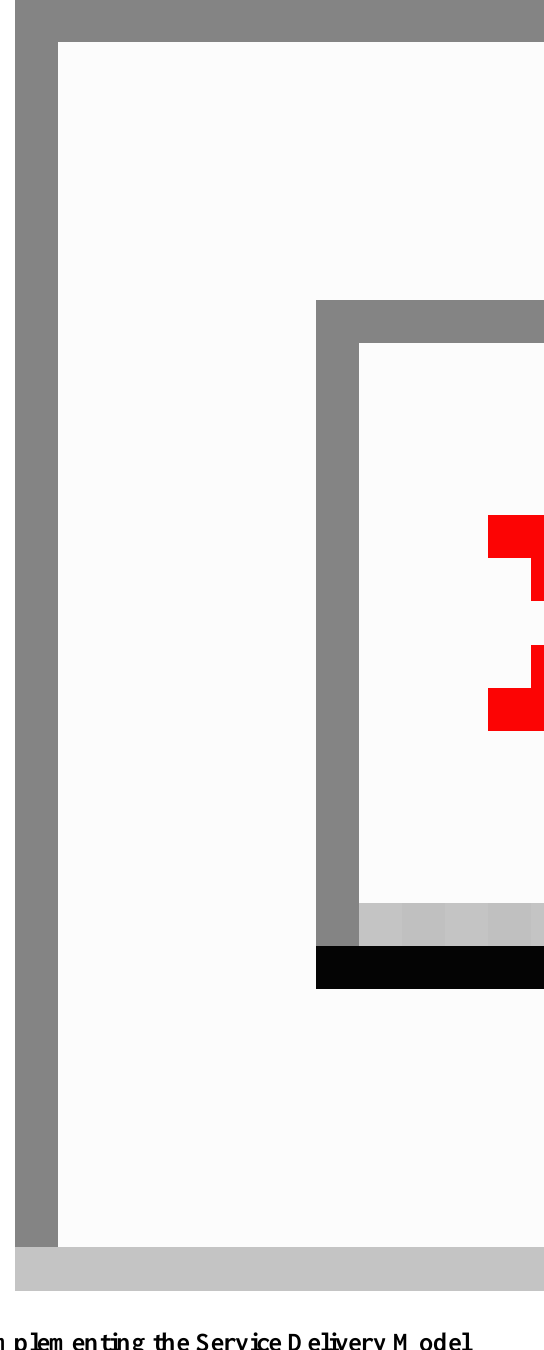
Figure 3. Screenshot of grading